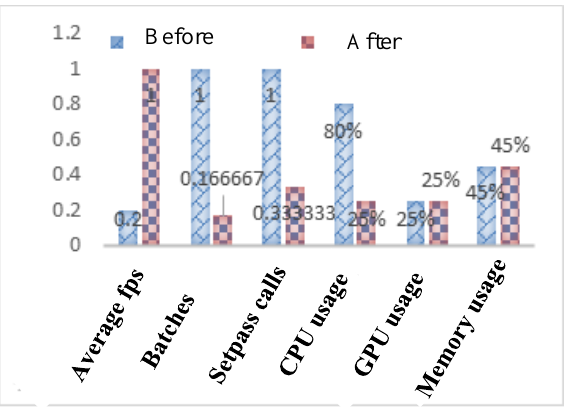
Figure 8. Comparison of performance parameters before and after static batch processing after normalization. The blue histogram depicts before static batch processing, whereas the red histogram shows after